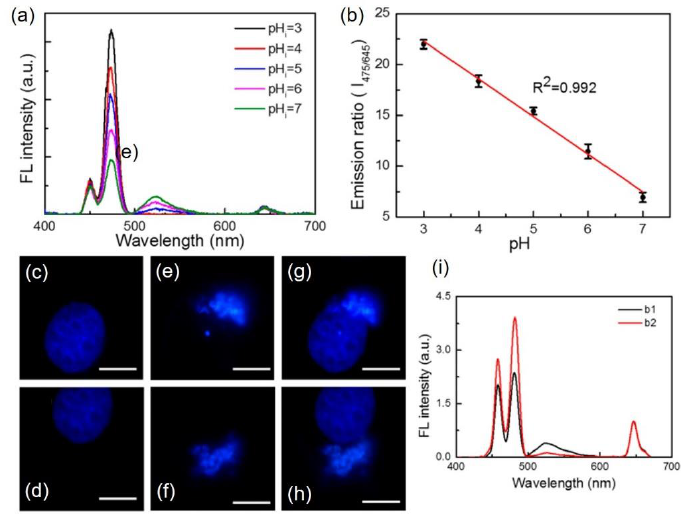
Figure 7. ( a ) Red emission normalized luminescence spectra of QBC939 cells (incubated with UCNPs) under 980 nm excitation at different pH. ( b ) Variation of the relative luminescence intensity ratio of 475 nm to 645 nm at different pH values: ( c , d ) images of the QBC939 cell’s nucleus under 405 nm excitation; ( e , f ) the upconversion images of different sites in single cell upon 980 nm light excitation; and ( g , h ) merged images of ( c & e ) and ( d & f ), respectively, in 10 µm scale bar. ( i ) The upconversion emission spectra of ( e , f ) sites of the cell, normalized at 645 nm (Reproduced from Ref. [30], Creative